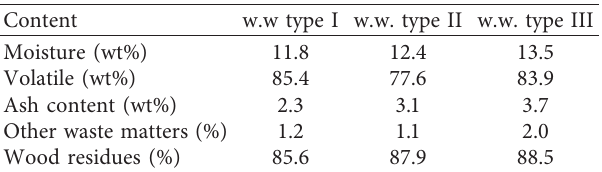
Table 1: Proximate analysis of urban w.w compositions and